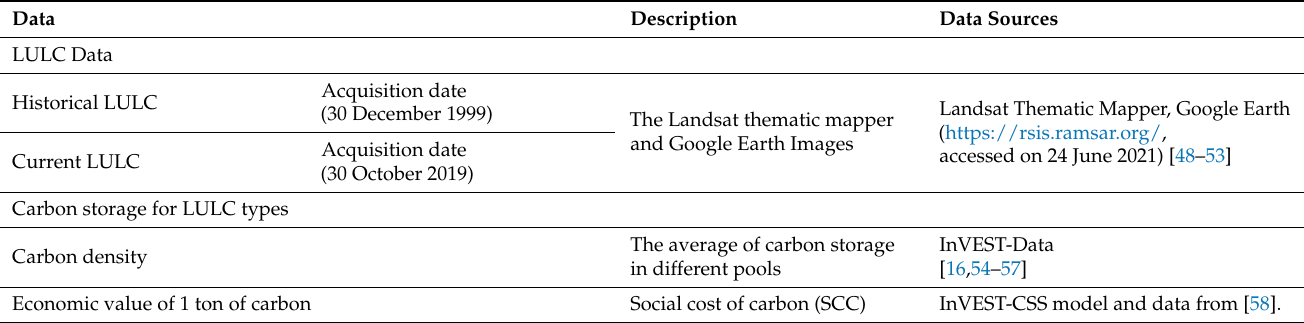
Table 2. Data used for the CBC modeling.